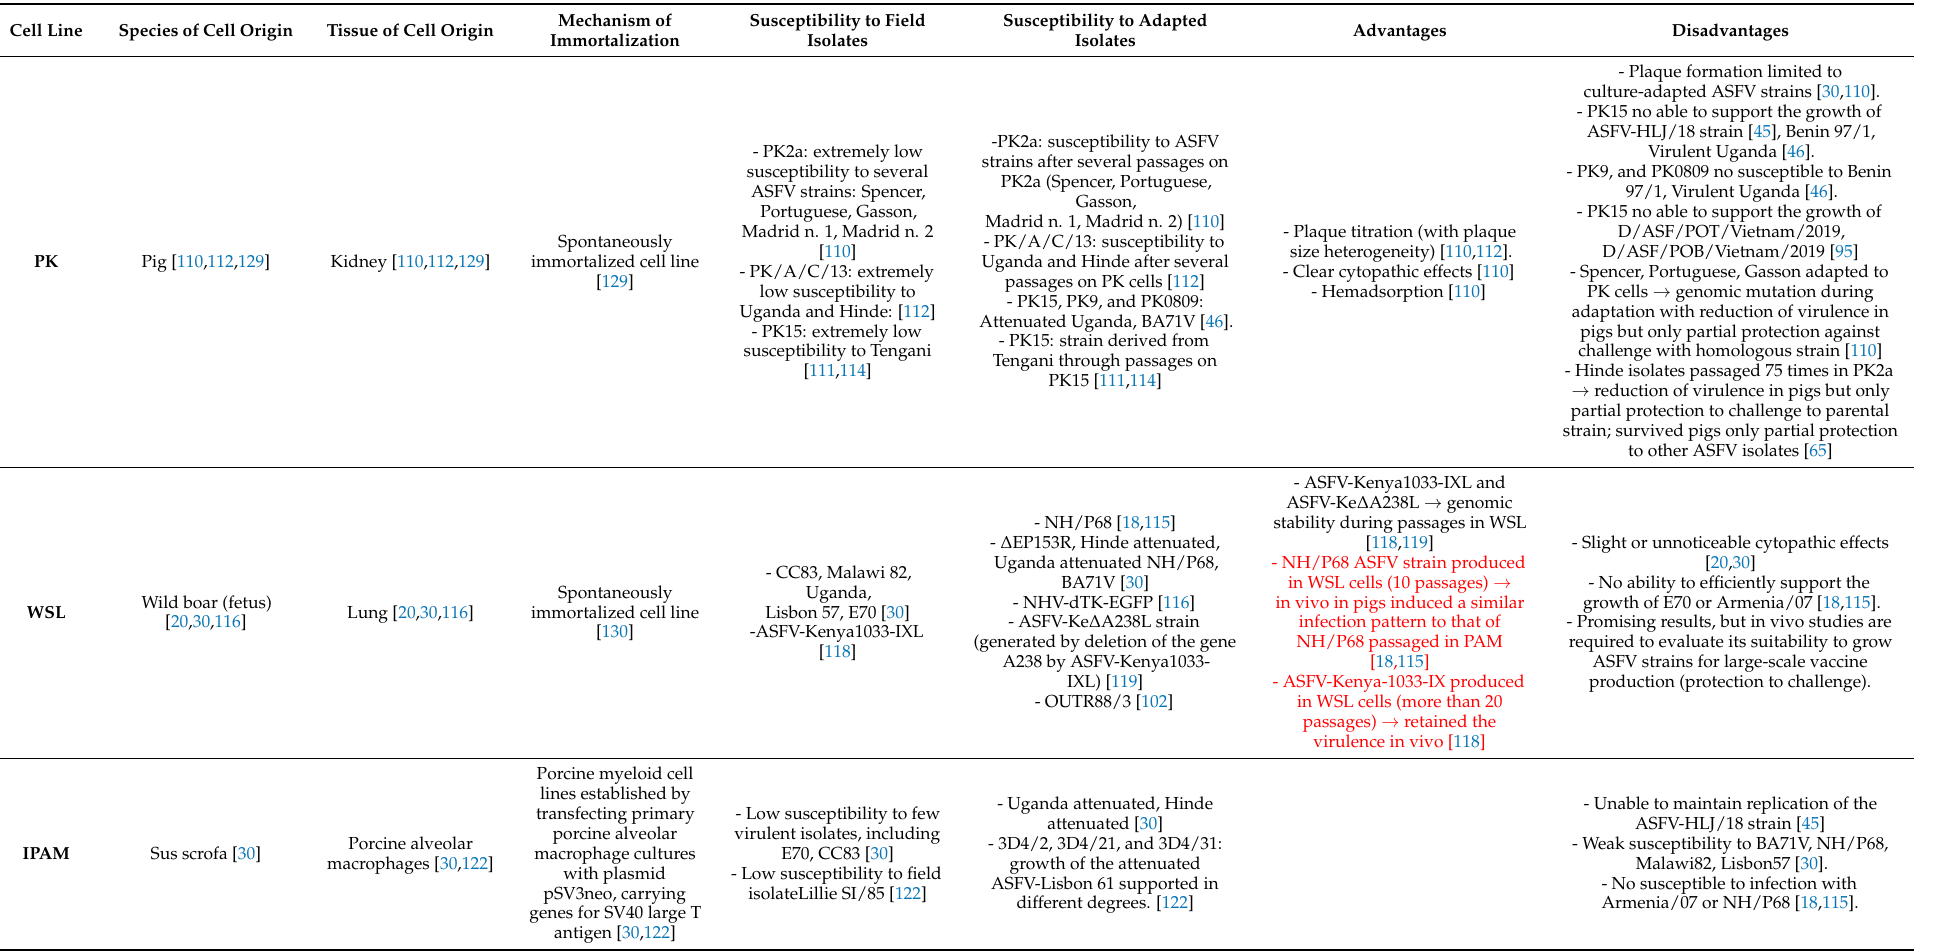
Table 2. Characteristics of porcine-derived continuous cell lines used for ASFV in vitro studies and the ability to support the growth of ASFV candidate